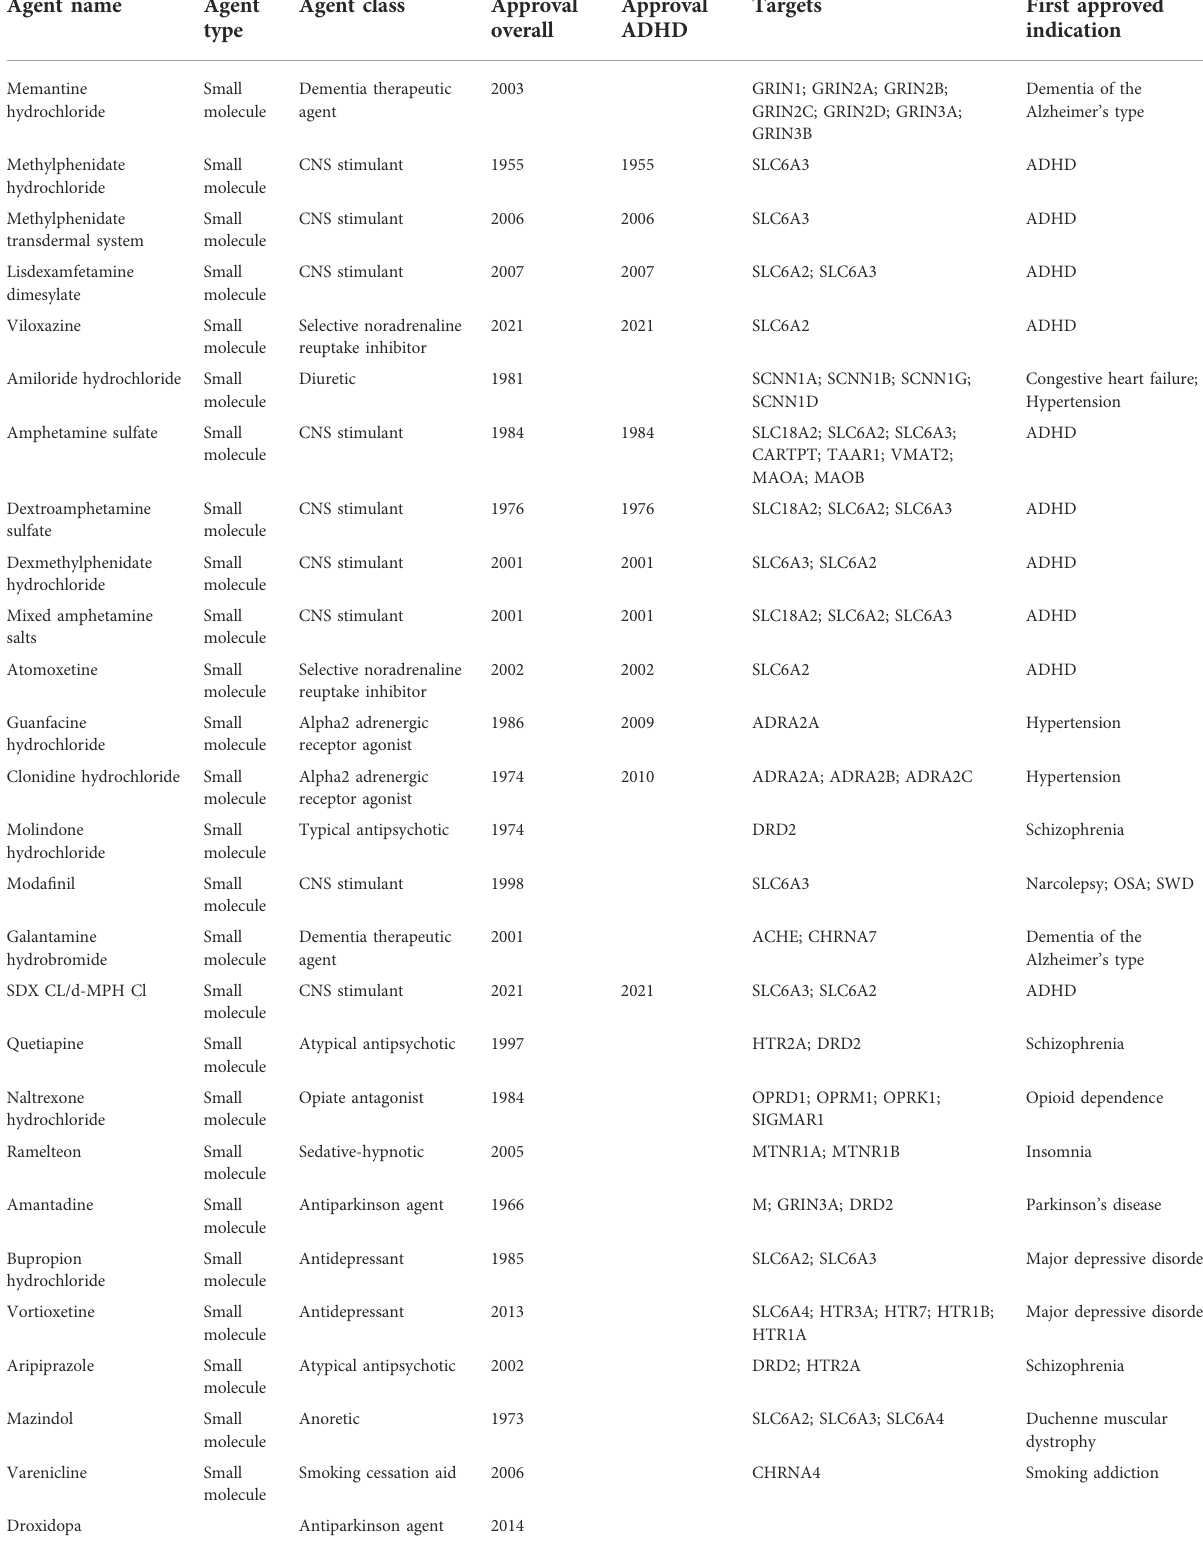
TABLE 1 Drugs approved for ADHD and other indications encountered in clinical